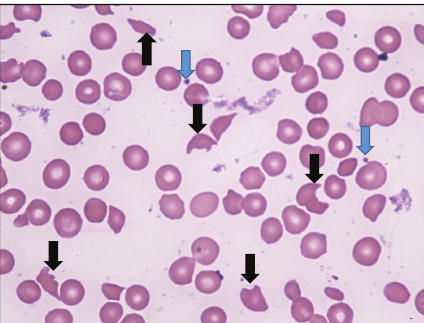
Figure 1: Peripheral smear shows moderate to severe schistocytes (black arrows) and very few platelets (blue arrows).